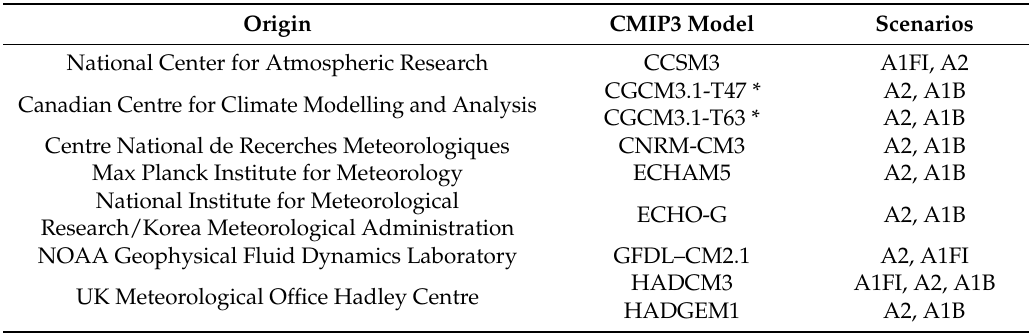
Table 2. Global climate modeling groups and their models. Source: High-Resolution National Climate Change Dataset. Those marked with * begin in 1961. All other models contain daily time series from 1960 to